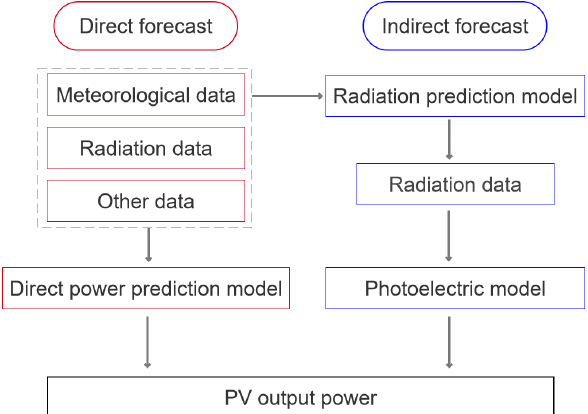
Figure 3. Flow chart of direct and indirect forecasting methods.